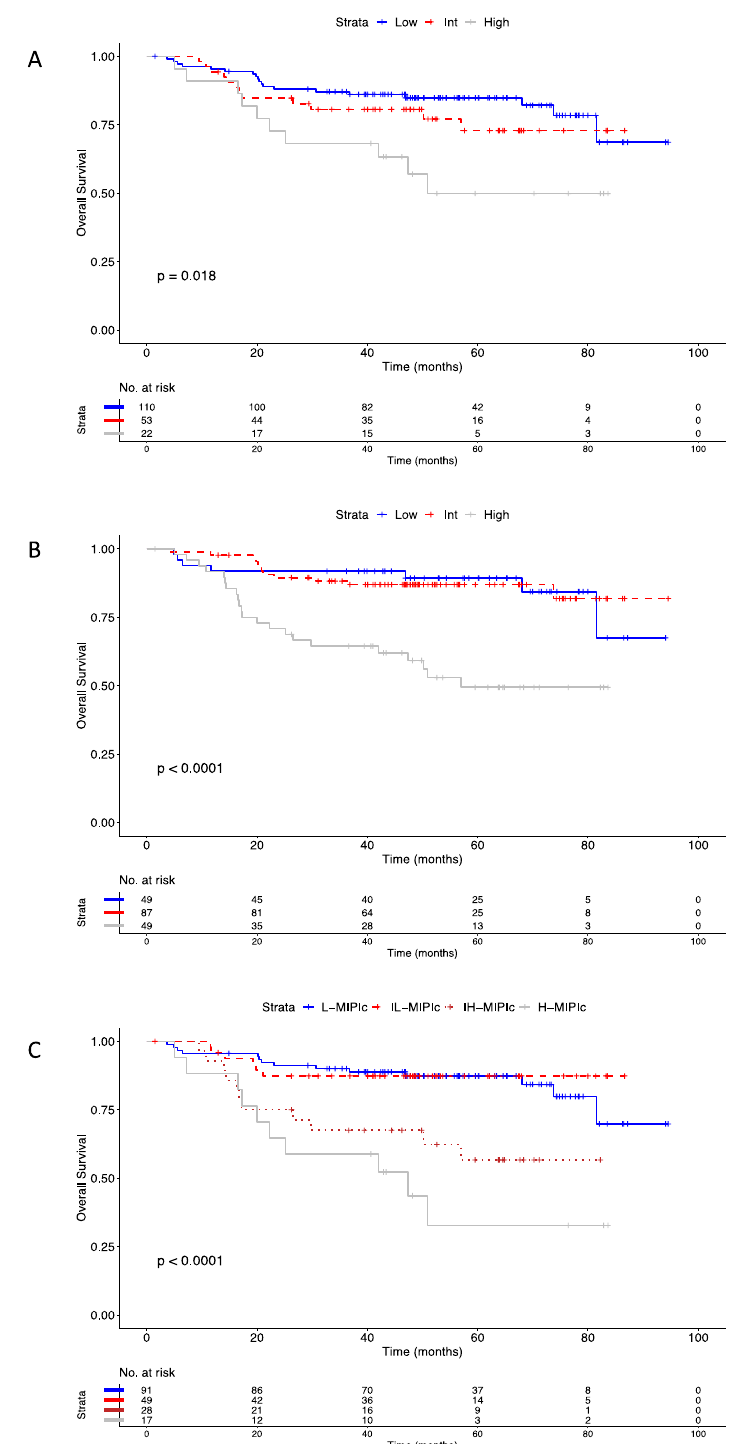
Figure 4. K-M survival plots of patients with MCL, from training-set, separated according to known prognostic scores. ( A ) The MIPI-st classified 110 patients as Low risk, 53 patients as Int risk, and 22 patients as High risk. ( B ) The MIPI-b classified 49 patients as Low risk, 87 patients as Int risk, and 49 patients as High risk. ( C ) The MIPI-c classified 91 patients as Low risk, 49 patients as Int Low risk, 28 patients as Int High risk, and 17 patients as High risk. Abbreviations. OS: overall survival; K-M: Kaplan-Meyer; MCL: mantle cell lymphoma; MIPI: international MCL prognostic index; MIPI-st: MIPI-standard; MIPI-b: MIPI-biologic; N: number; Int: intermediate; CI: confidence interval; HR: hazard